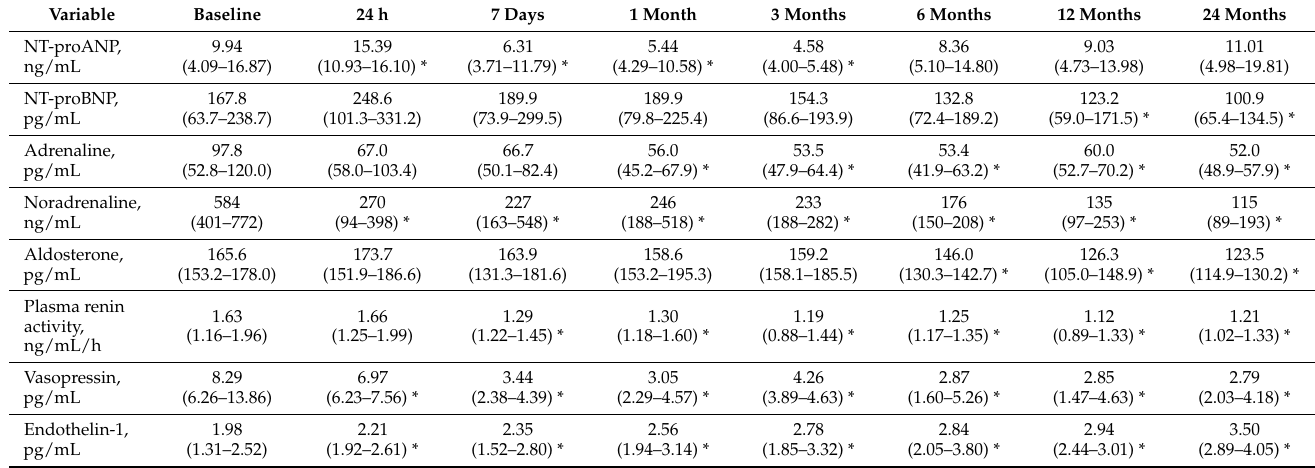
Table 3. Sequential changes in natriuretic peptides and adrenergic markers from baseline to 24 months after LAAC. (*—the result was statistically